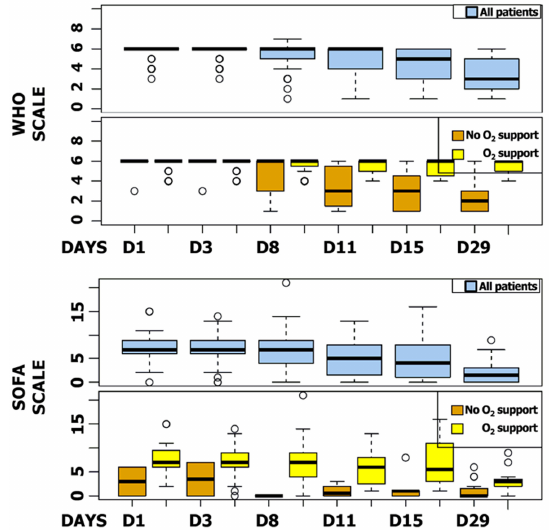
Figure 5. SOFA and WHO Scores Box Plot. SOFA and WHO scores at day 1, 3, 8, 11, 15, and 29 for all patients and regarding oxygen support. 3.6. Safety The most common adverse events were increased hepatic enzymes (31.8%), anemia (30.6%), renal impairment (28.2%), and hypotension (23.5%) (Table 4). Adverse events oc- curred both in patients with invasive and non-invasive ventilations (70.4% vs. 69.2%). Thirty-eight patients (44.7%) had serious adverse events. The most common serious ad- verse events were hypotension (22.3%), anemia (14.1%), renal impairment (15.3%), and deep-vein thrombosis (12.9%). Eleven patients (12.9%) discontinued remdesivir treatment prematurely because of limiting toxicity. Table 4. Adverse events.